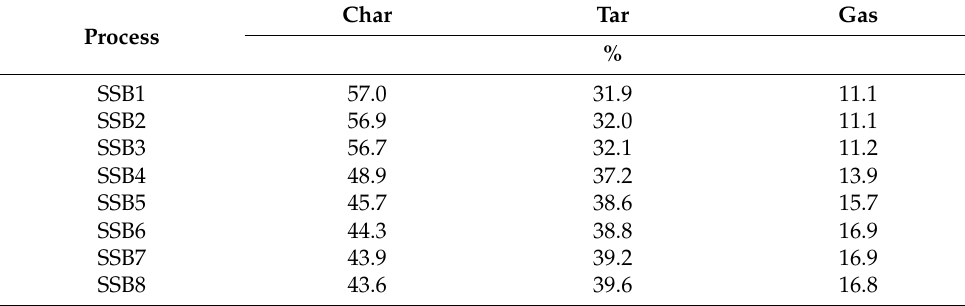
Table 3. The influence of pyrolysis condition on the products